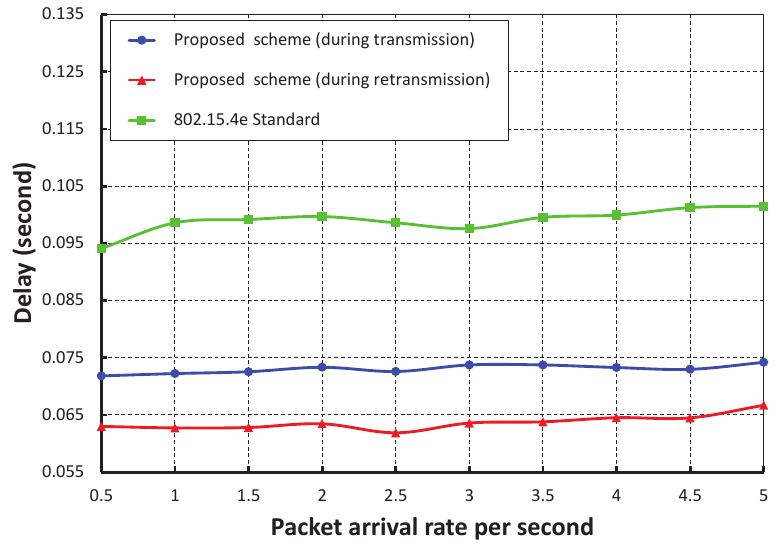
Figure 16. Comparison of the delay of our proposed scheme with the IEEE 802.15.4e